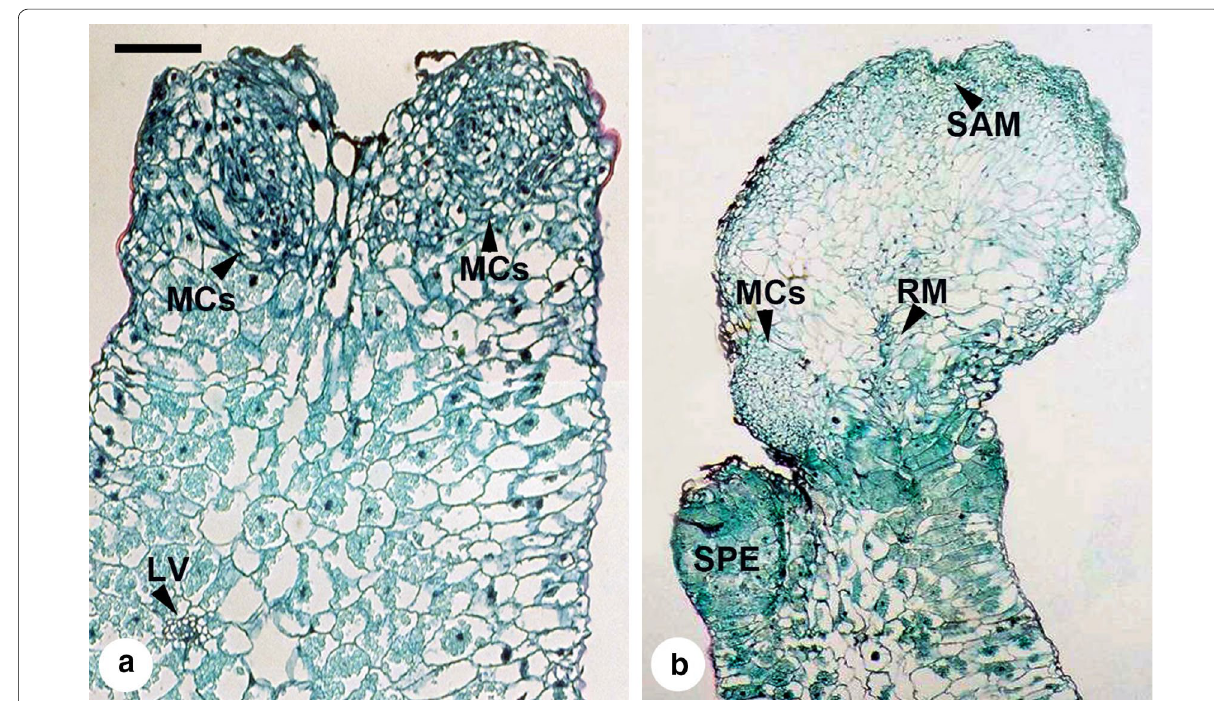
Fig. 3 Histology of direct somatic embryogenesis from leaf explants of Tolumnia Louise Elmore ‘Elsa’. a meristematic cells (MCs) originated from the mesophyll cells of a leaf explant ( Scale bar 0.1 mm); leaf vein (LV); b a somatic proembryo (SPE) and a somatic embryo developed the bipolar